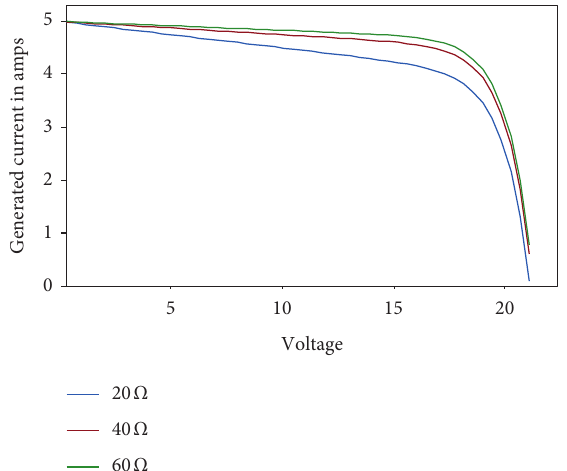
Figure 8: Simulated I-V plot of varying R